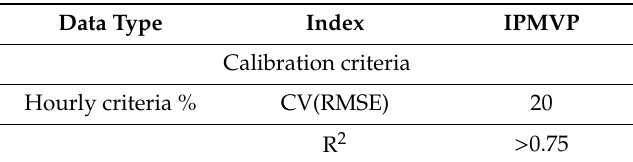
Table 1. Calibration limits for IPMVP 1